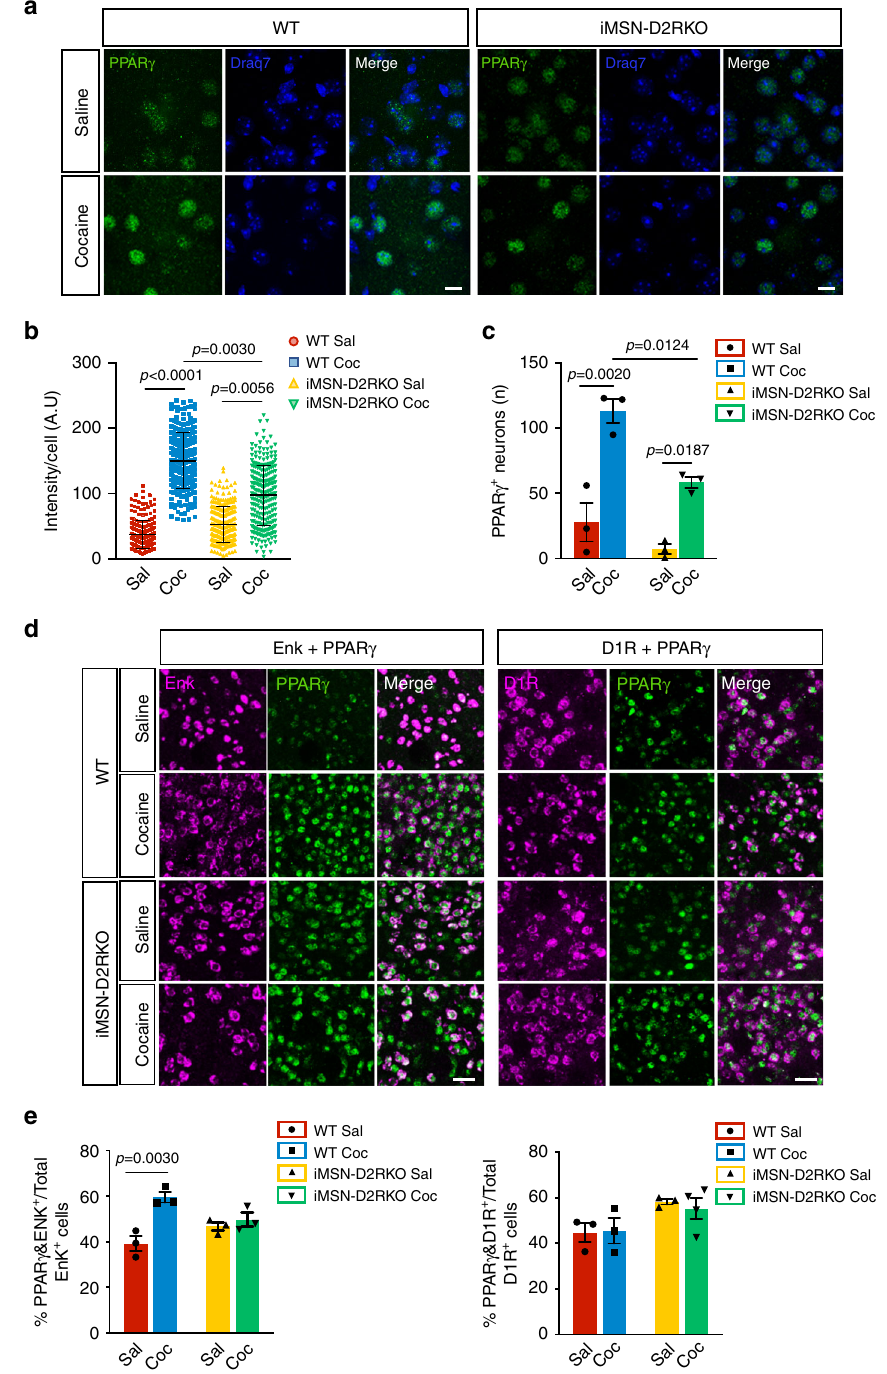
Fig. 5 Cocaine-induced nuclear PPAR γ is impaired in iMSN-D2RKO mice. a Immunolabeling of PPAR γ and nuclei on striatal sections of saline and cocaine treated WT and iMSN-D2RKO mice. Scale bar: 25 µ m. b Quanti fi cation of the fl uorescent intensity of PPAR γ immunolabeling in WT and iMSN-D2RKO mice treated with saline (Sal; WT: red circles; iMSN-D2RKO: yellow upward triangles) or cocaine (Coc; WT: blue squares; iMSN-D2RKO: green downward triangles). Data were analyzed by two-way ANOVA using the mean ± SD of intensity/cell for each biological replicate ( n = 4/group) (Genotype: F (1, 12) = 8.458, p = 0.0131; Treatment: F (1, 12) = 91.23, p < 0.0001; Interaction: F (1, 12) = 12.81, p = 0.0038), Tukey ’ s multiple comparison test. c Quanti fi cation of PPAR γ positive neurons with the indicated treatment ( n = 3/group). Signi fi cance was calculated using two-way ANOVA (Genotype: F (1, 8) = 16.87, p = 0.0034; Treatment: F = 54.77, p < 0.0001; Interaction: F = 3.474, p = 0.0993) Tukey ’ s multiple comparison test. d Double in-situ/ (1, 8) (1, 8) immuno fl uorescence for Enkephalin (Enk) or D1R mRNA and PPAR γ protein in cocaine treated WT and iMSN-D2RKO mice. Scale bar: 50 µ m. e Percentage of PPAR γ - and Enk- or D1R-positive cells in cocaine and saline treated WT and iMSN-D2RKO mice (Enk: n = 3/group; D1R: n = 3 WT Sal, n = 3 WT Coc, n = 3 iMSN-D2RKO Sal, n = 4 iMSN-D2RKO Coc). Two-way ANOVA (Enk: Genotype: F = 0.1782, p = 0.6841; Treatment: F = 18.69, p = 0.0025; (1, 8) (1, 8) Interaction: F (1, 8) = 10.53, p = 0.0118; D1R: Genotype: F (1, 9) = 7.117, p = 0.0257; Treatment: F (1, 9) = 0.06215, p = 0.8087; Interaction: F (1, 9) = 0.1943, p = 0.6697). Tukey ’ s multiple comparison test. Data in c and e are presented as mean values ±